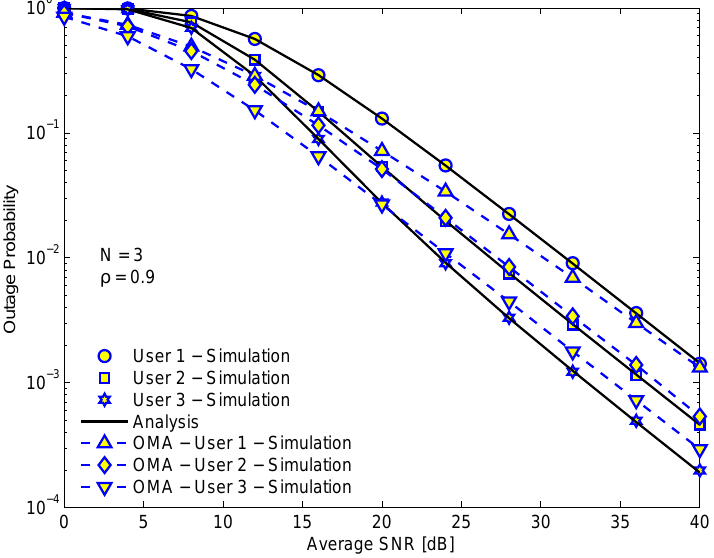
Figure 2. The outage probability of each user in energy harvesting (EH)-NOMA and EH-OMA relaying systems versus the average SINR. ρ = 0.9, the number of relays N =